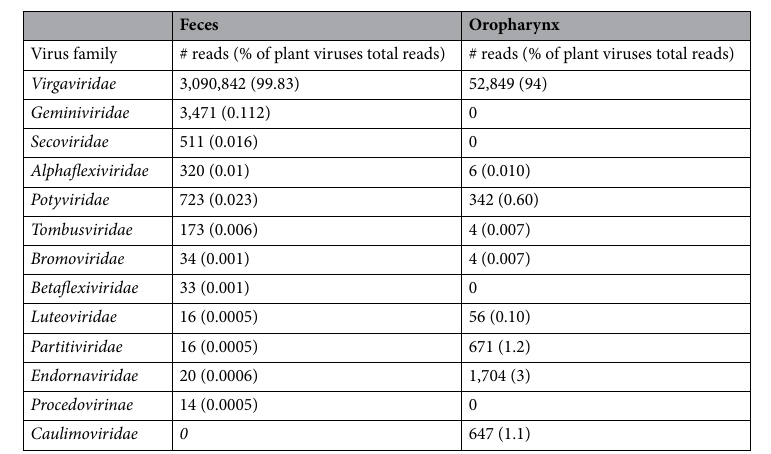
Table 3. Abundance of sequence reads from the plant virus families